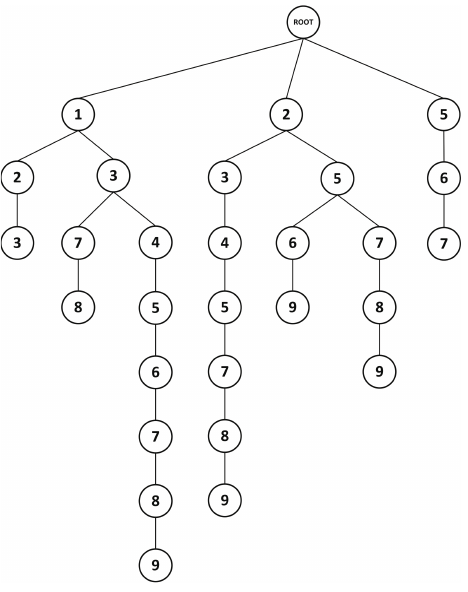
Figure 2. The sample trie created for the dataset in Table 1.